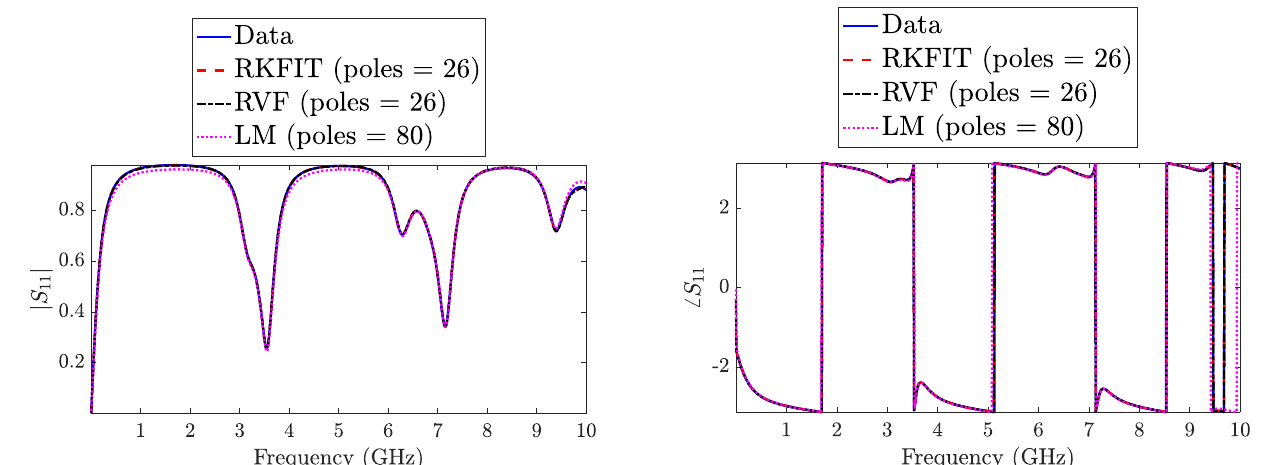
Figure 7. Comparison ofRKFIT with RVF and LM models with given data for S 11 of Section 3.2.